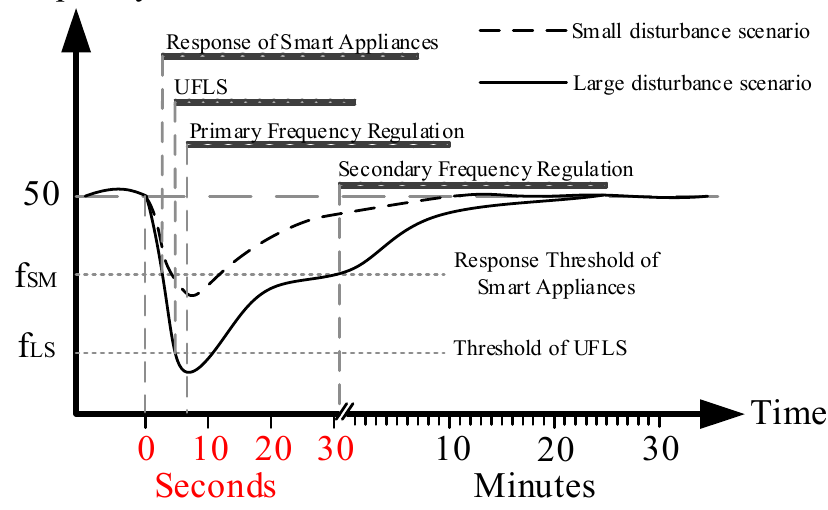
Figure 3. Dynamic curve of frequency after a disturbance in a smart grid.